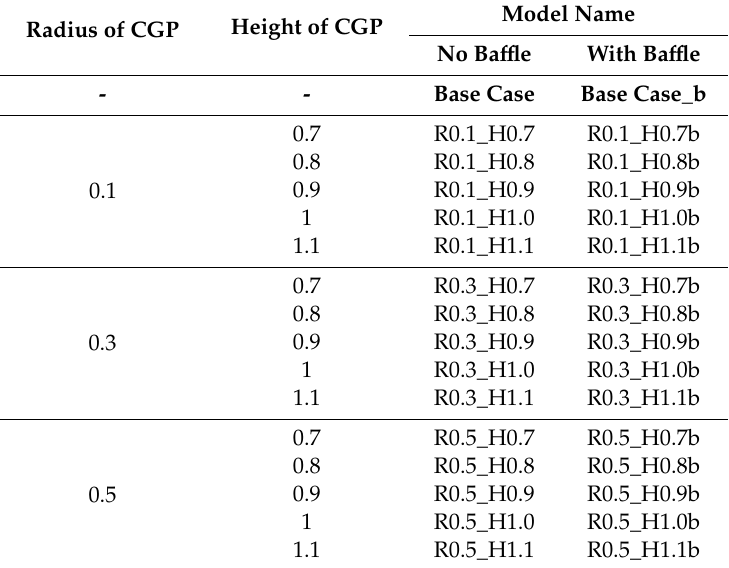
Table 1. Two groups of models classified as with or without a ba ffl e. Each group included a base case and fifteen models with di ff erent CGP geometries, where ‘R’ denotes the radius, ‘H’ denotes the height, ‘b’ denotes the ba ffl e, and the numbers give the corresponding values in